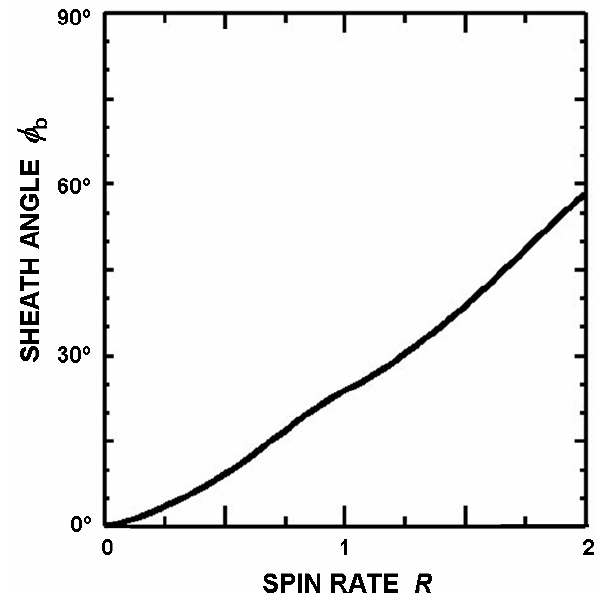
Fig. 4. The average normalized bellyband potential, V M / K, and the average spin pole potential, V P / K, versus R . The dashed lines indicate the threshold values.